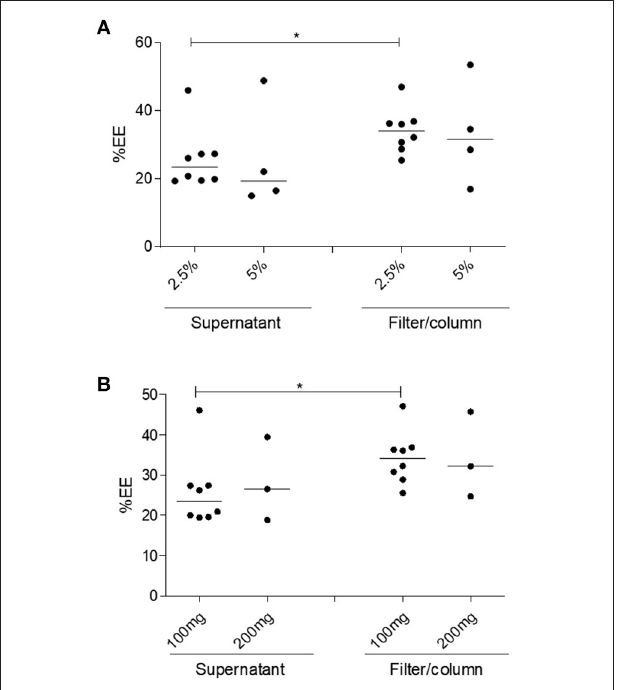
FIGURE 5 | Evaluation of the influence of PLGA and PEG concentration on the %EE of 17-DMAG in NP2-17-DMAG. The effect of varying amounts of PEG (A) and PLGA (B) on the %EE of 17-DMAG in NP2-17-DMAG was determined by filter/column or supernatant analysis methods as described in section Material and Methods. Measurements were performed using HPLC. Each point represents an individual experiment. Mann-Whitney test, * p < 0.05.